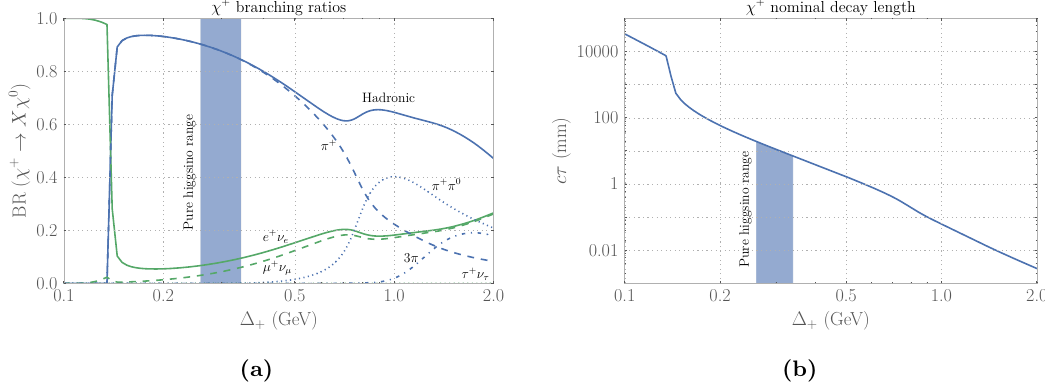
Figure 10. Branching ratios (left) and nominal decay length (right), for the charged component of an electroweak doublet with hypercharge 1 ⁄ 2 and Dirac mass m (cid:31) = 1 : 1 TeV, as a function of (cid:1) + , the splitting between the charged and neutral states. Note that the partial widths are highly insensitive to the overall mass